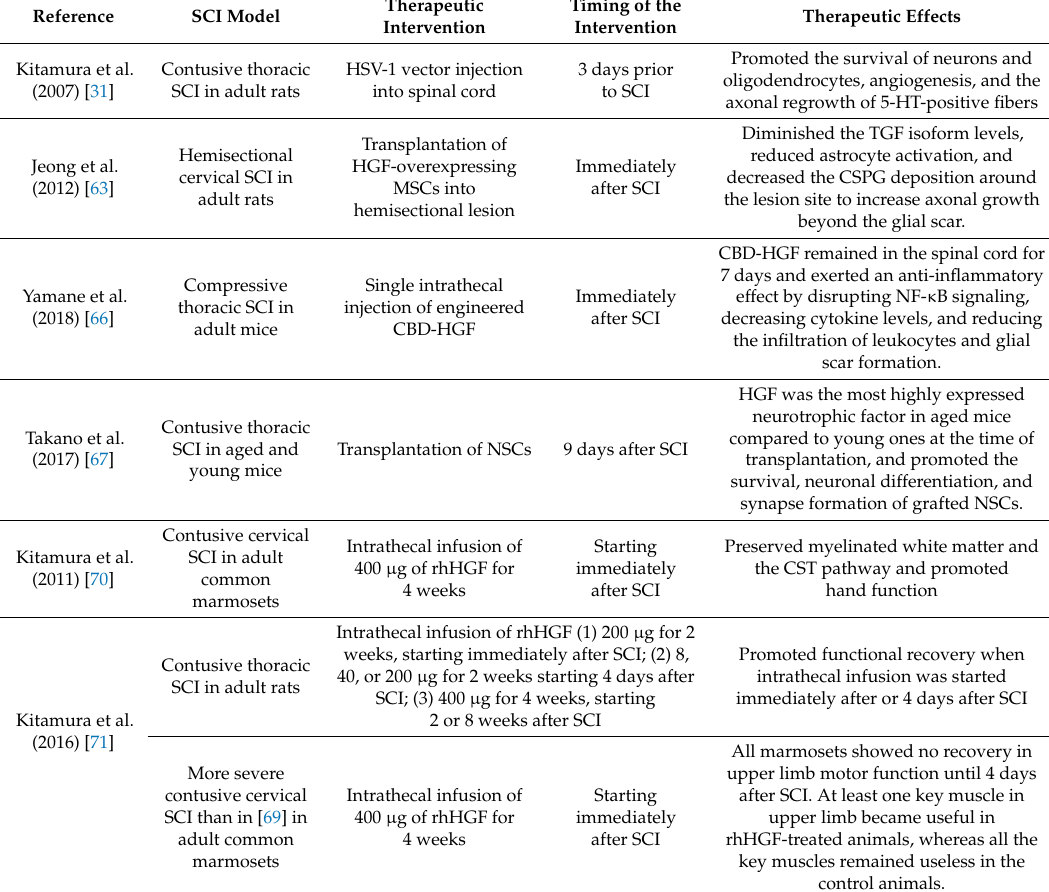
Table 2. Therapeutic mechanisms of HGF on the injured spinal cord, determined using different therapeutic interventions in different types of SCI. SCI: spinal cord injury; HSV-1: herpes simplex virus-1; MSCs: mesenchymal stem cells; CSPG: chondroitin sulfate proteoglycans; CBD-HGF: engineered HGF fused with a collagen-binding domain; NSCs: neural stem cells; CST: corticospinal tract; rhHGF: recombinant human